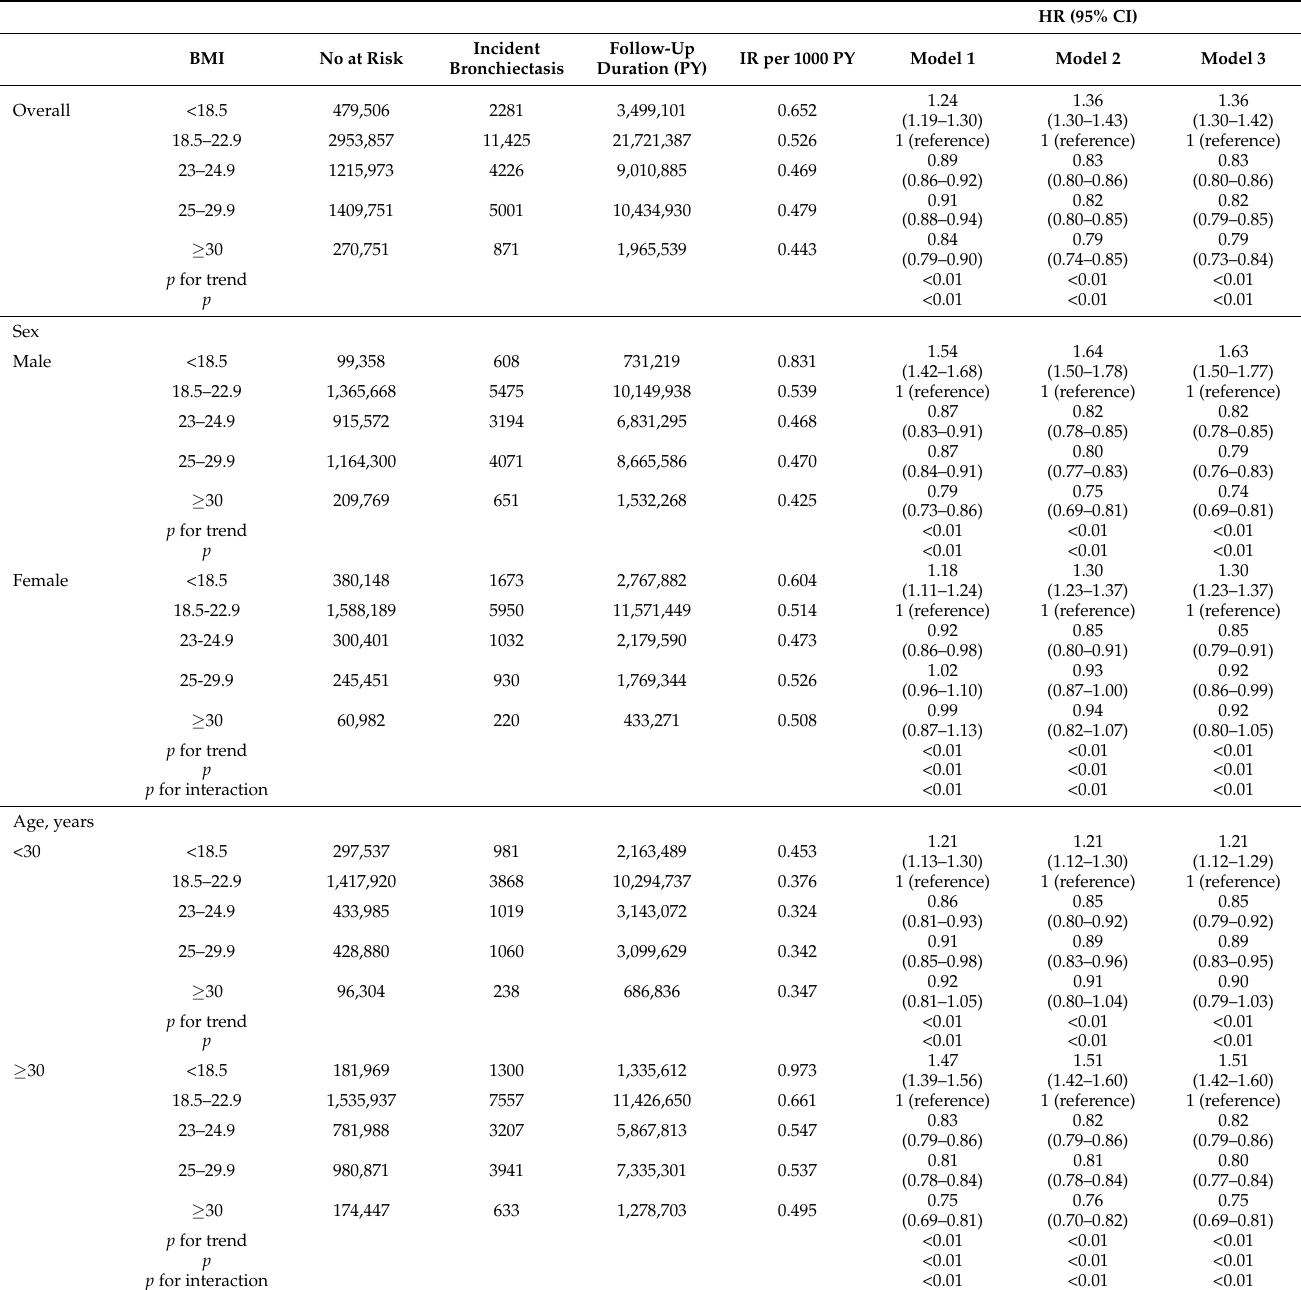
Table 2. Risk of bronchiectasis according to BMI